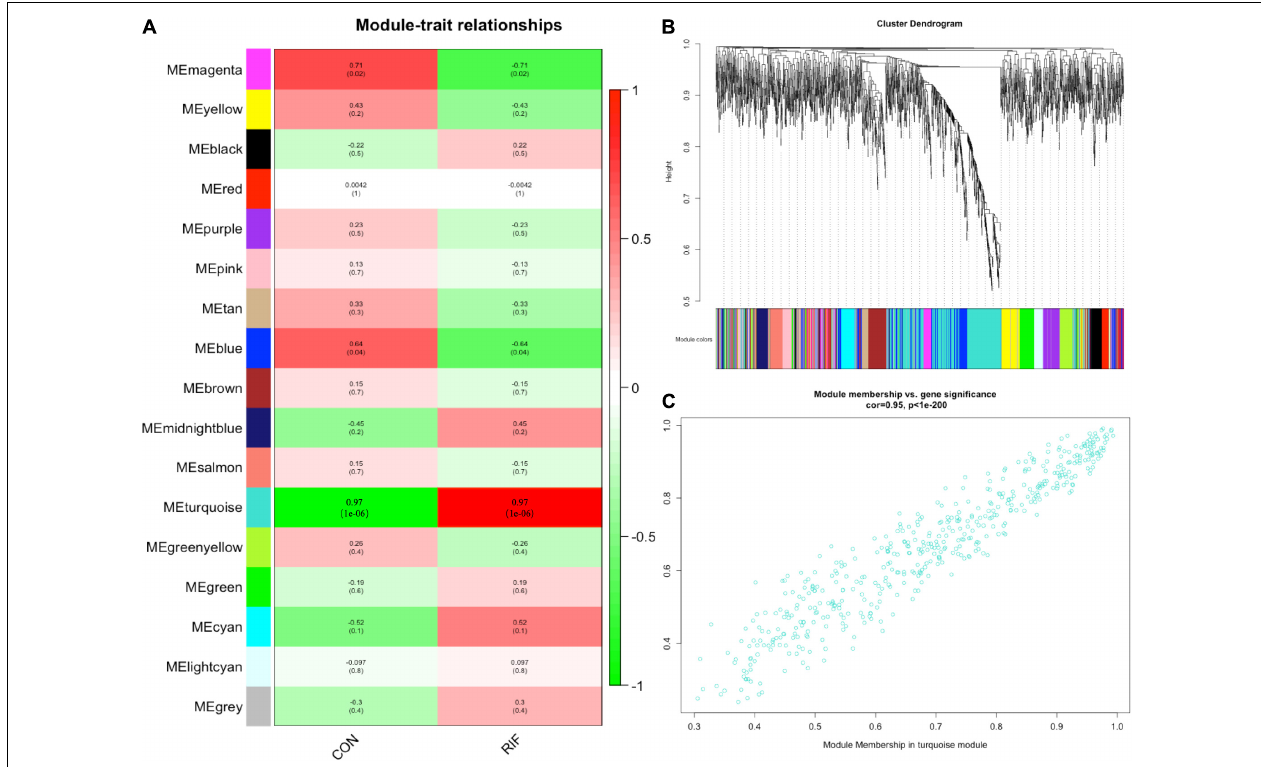
FIGURE 2 | Weighted gene correlation network analysis. (A) The relationships between the corresponding modules and clinical phenotypes. (B) The modules selected with a minimum module size of 50 for further analysis. (C) The module membership in the turquoise module.